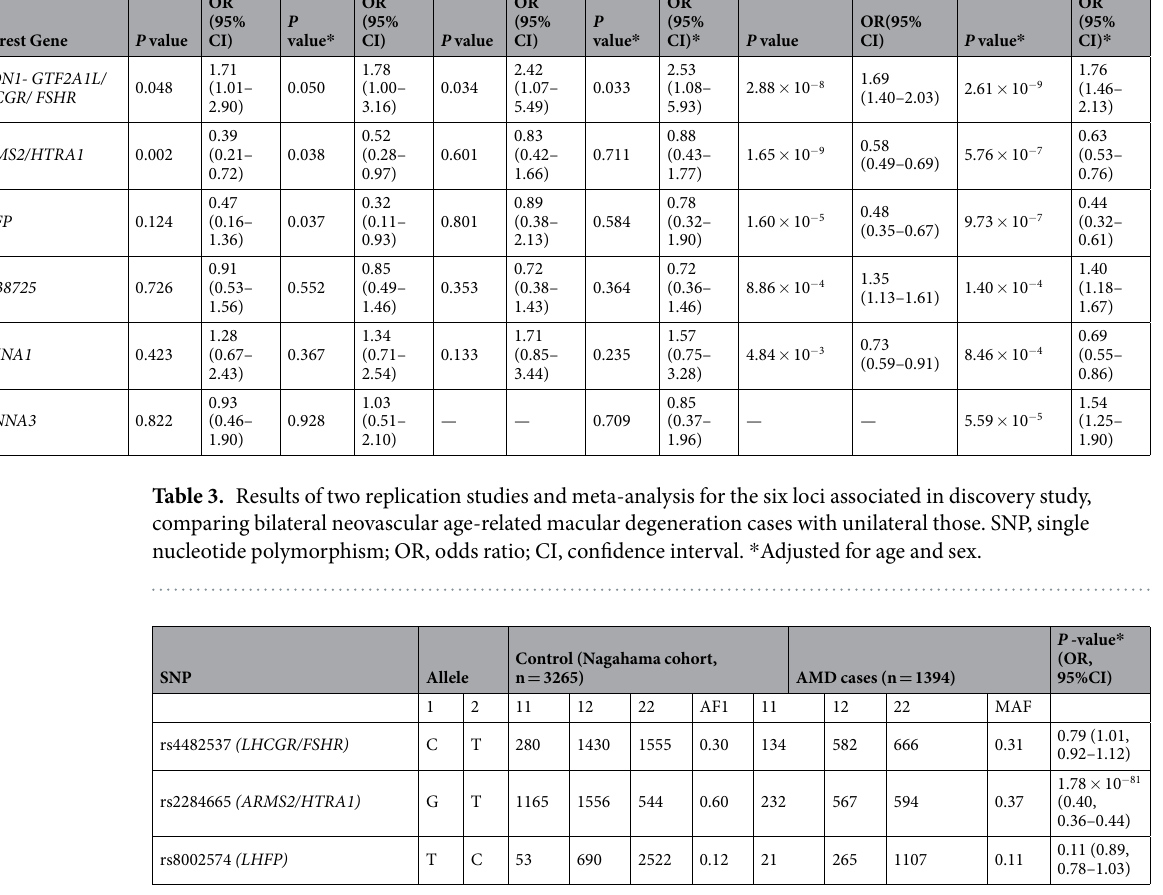
Table 4. Results of the association study for three loci about the occurrence of AMD, comparing all neovascular age-related macular degeneration cases with Japanese general population cohort. SNP, single nucleotide polymorphism; AF, allele frequency; MAF, minor allele frequency; OR, odds ratio; CI, confidence interval, *